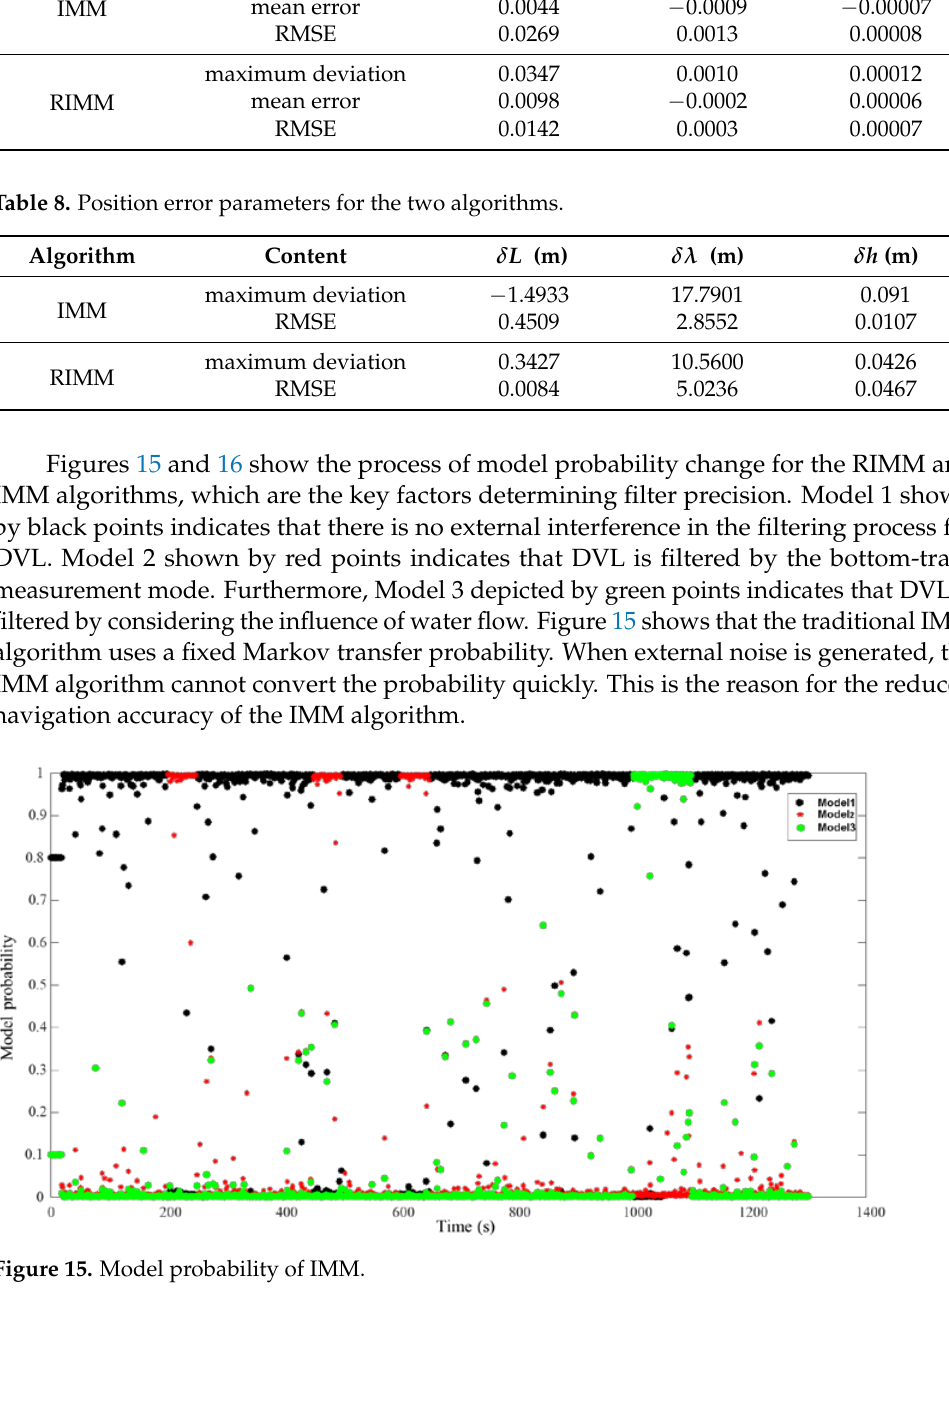
Figure 16. Model probability of RIMM. 5. Conclusions In this paper, a novel tightly integrated navigation system of SINS, DVL, and PS was proposed for complex underwater environments. The tightly integrated navigation sys- tem is based on the DVL water-track velocity measurement model and the DVL bottom- track velocity measurement model. The RIMM algorithm was further proposed, which is based on a tightly integrated navigation system of SINS, DVL, and PS. This algorithm can detect the outliers and abnormal noises of DVL beams and use the variable Markov tran- sition probability matrix to achieve fast conversion of different models. Simulating the motion process of the AUV in a complex environment, the results show that compared with the TLIN algorithm in terms of maximum deviation of latitude and longitude, the RIMM algorithm improves the accuracy by 39.1243 m and 26.4364 m, respectively. Com- pared with the TTIN algorithm, the RIMM algorithm also improves latitude and longitude accuracy by 1.8913 m and 11.8274 m, respectively. A comparison with IMM also shows that RIMM improves the accuracy of latitude and longitude by 1.1506 m and 7.2301 m, respectively. The proposed theoretical method effectively limits the impact of different environmental noises on the tightly integrated navigation system and improves the navi- gation accuracy of the entire navigation system.